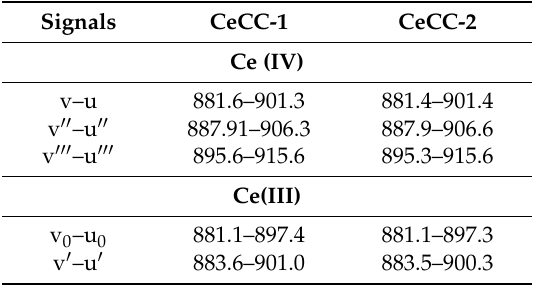
Figure 13. XPS spectra of Ce3d. ( a ) CeCC-1. ( b ) CeCC-2. Table 5. Energy assigned to peaks of Ce3d signals